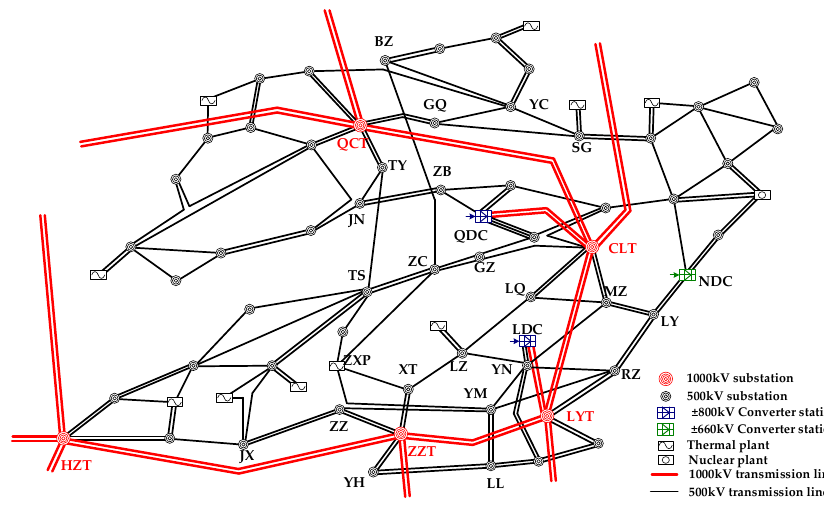
Figure 5. Actual AC/DC interconnected power system. Table 3. Computation Results of Edge Betweenness.